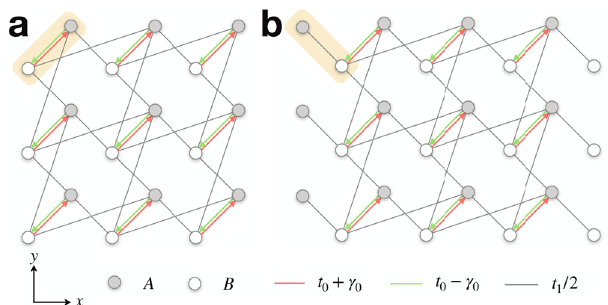
Fig. 2 Schematic views of the two-dimensional tight-binding model under open boundary condition (OBC) along x direction. The gray and white circles represent the two sites A and B , and the yellow blocks indicate the selection of the primitive cell. The non-reciprocal hopping terms with parameters t 0 ± γ 0 are denoted by orange and green lines with arrows, while the reciprocal hopping terms with parameter t 1 /2 are denoted by gray lines. a Lattice model under OBC 1 . b Lattice model under OBC 2